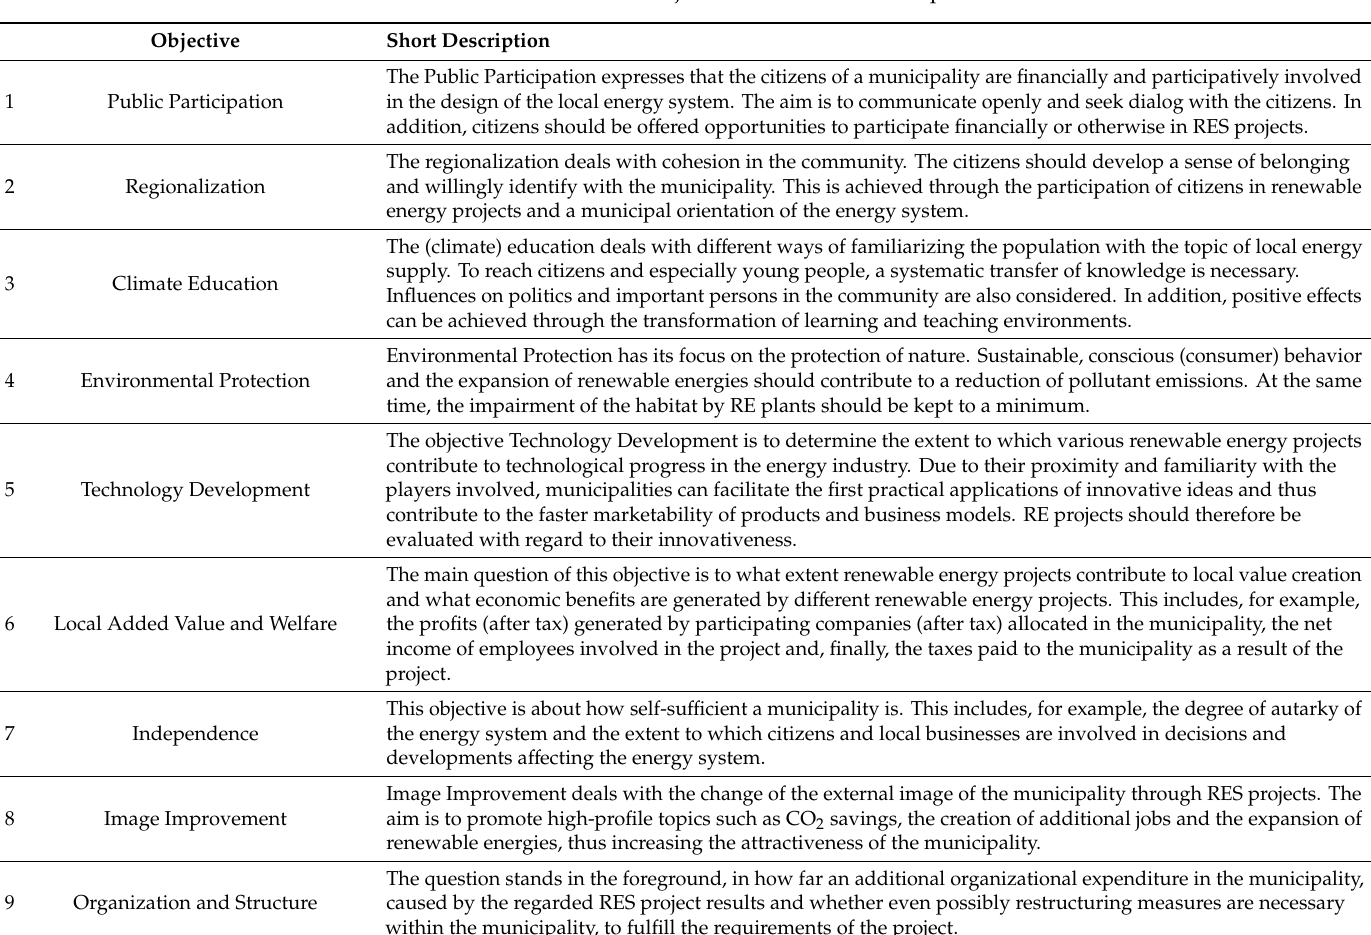
Table A1. Elaborated main objectives and a short